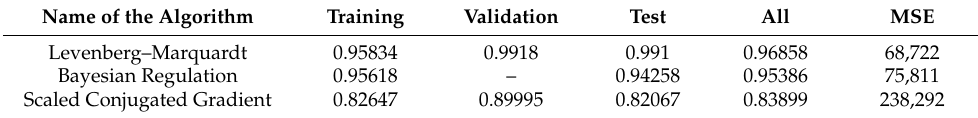
Table 3. Quantitative regression analysis of various optimization algorithms of ANN.